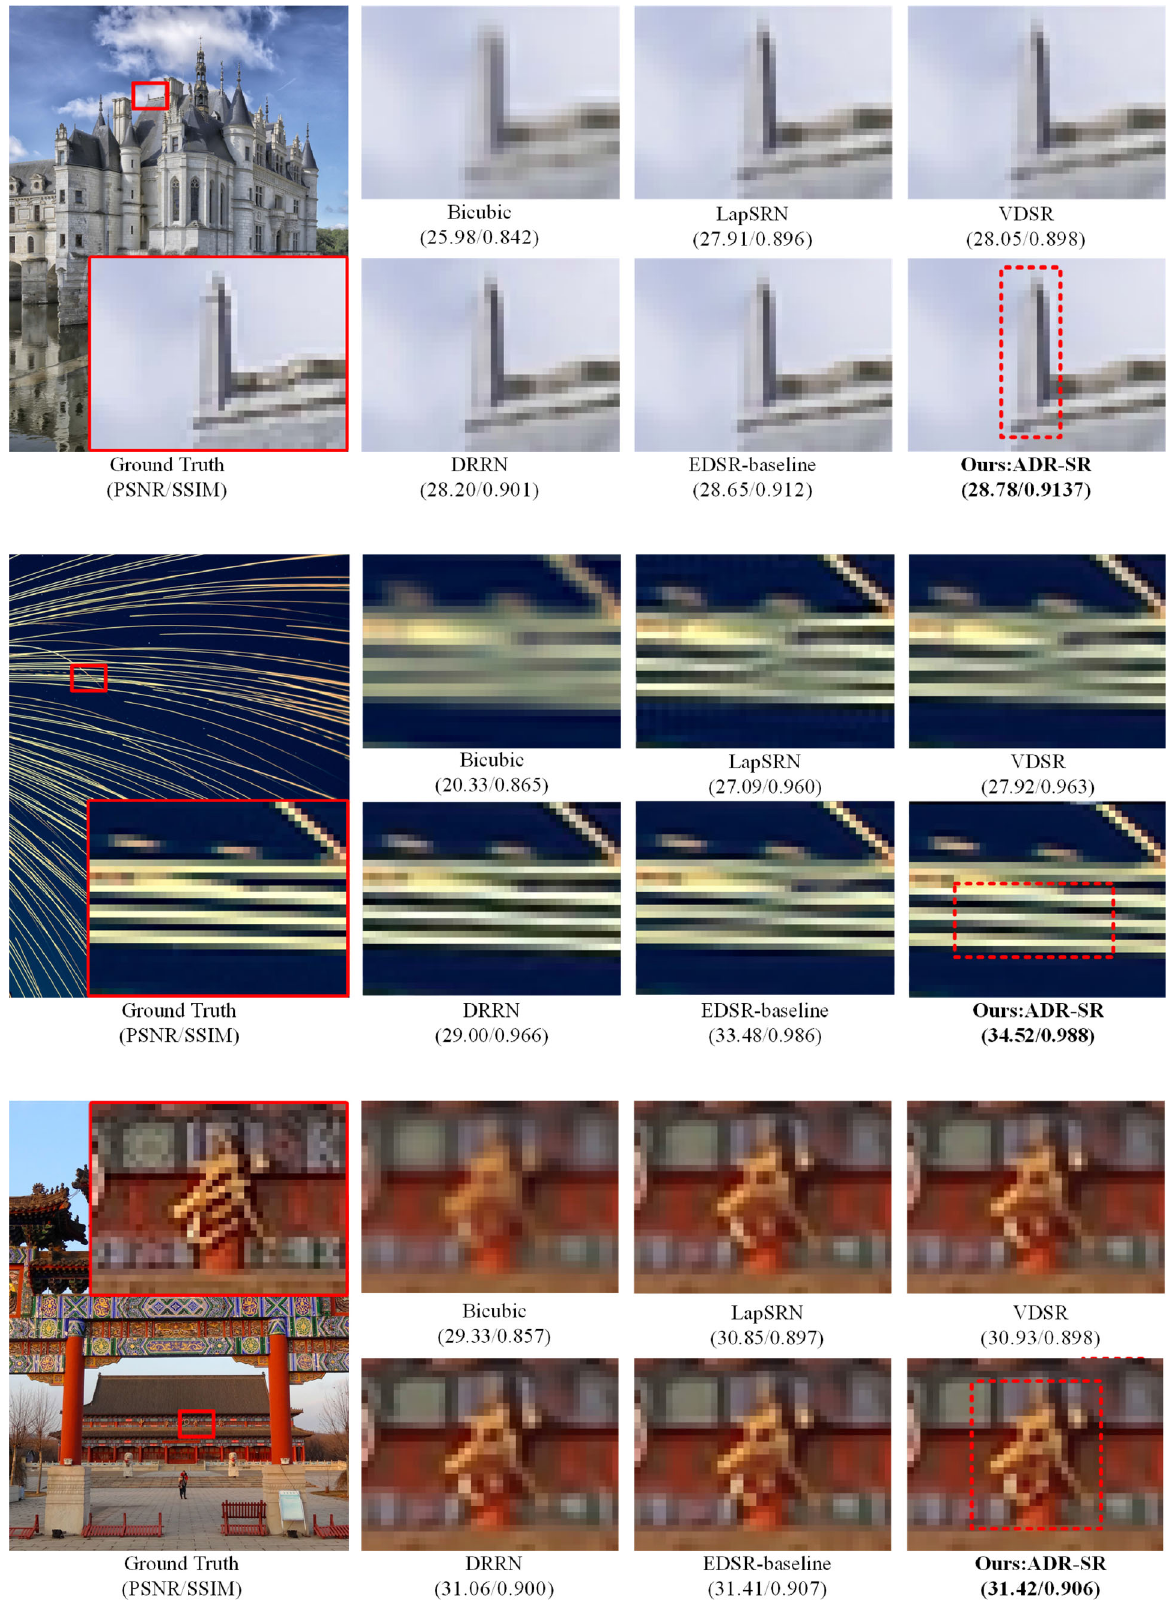
Fig. 7 Comparison of experimental effects of DIV2K validation